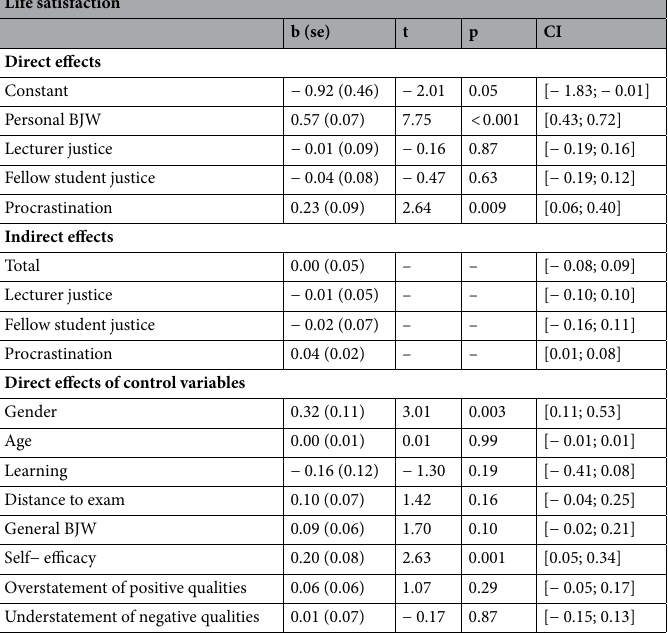
Table 2. Results of bootstrap mediation analyses for life satisfaction including control variables (N = 291 university students). BJW = Belief in a just world; For gender, 1 = female and 2 = male. Psychological variables ranged from 1 to 6 with lower values indicating stronger endorsement of the constructs, procrastination ranged from 1 to 5 with higher values indicating stronger endorsement of the constructs. Values